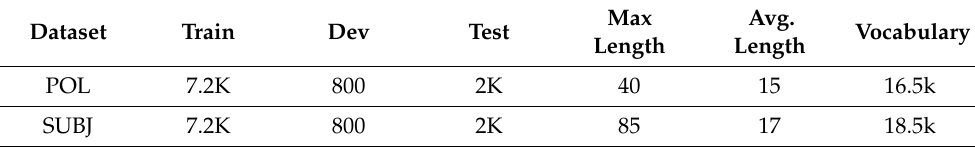
Table 1. Statistics of the datasets used in this paper after preprocessing and output of keras tokenizer.